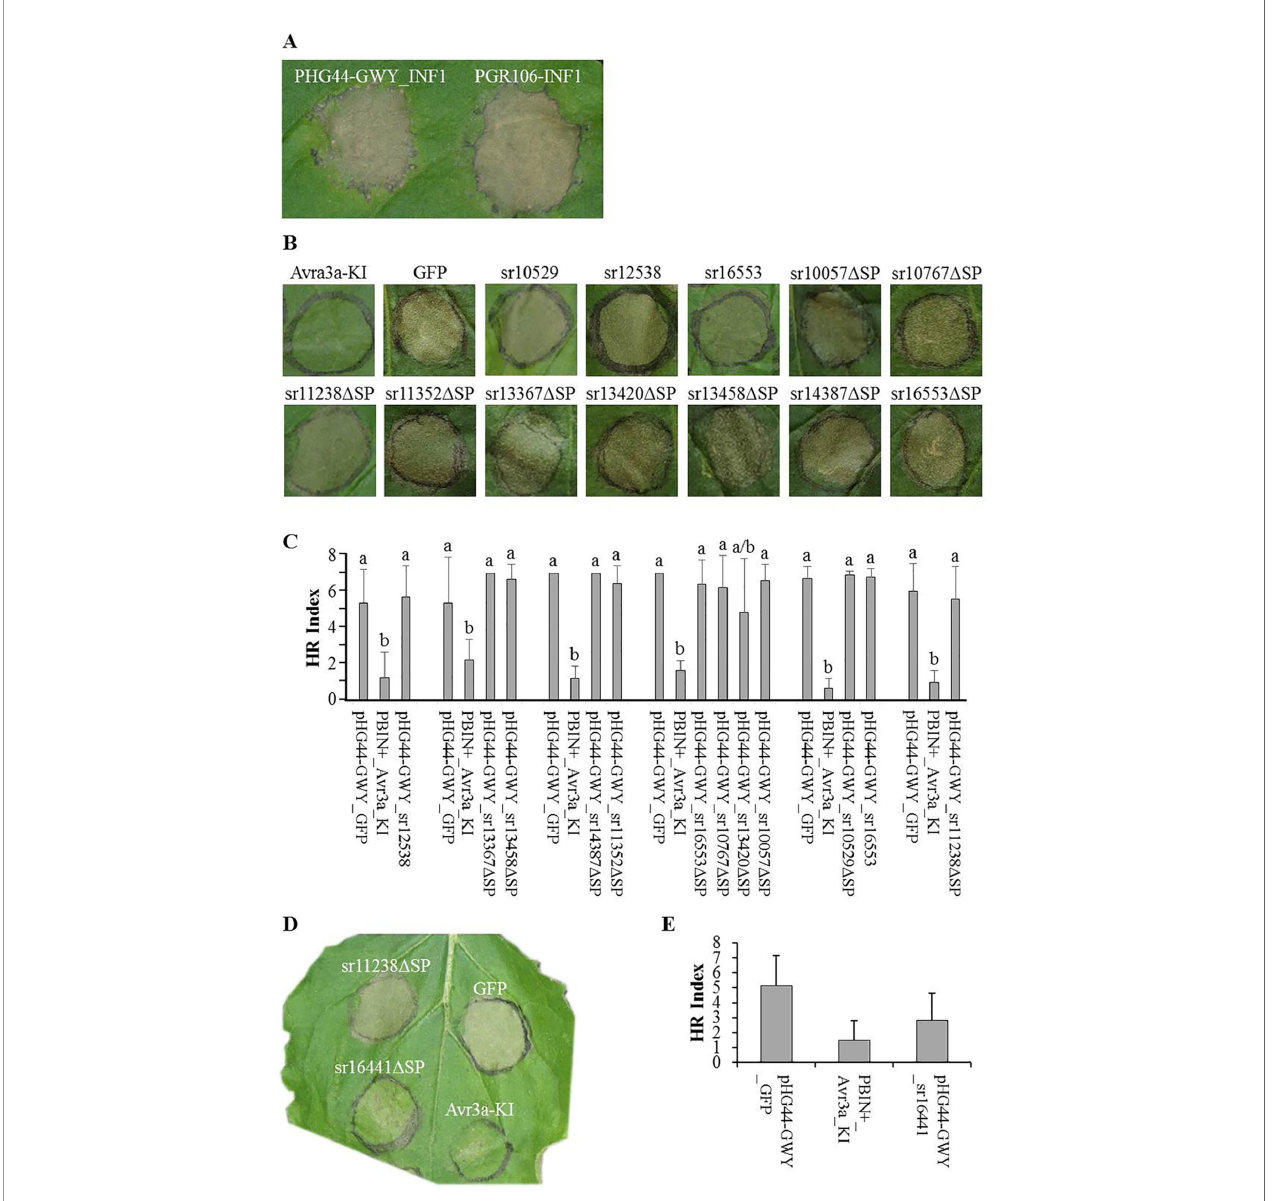
FIGURE 3 | Cell death suppression assays. Agrobacterium strains carrying effectors were in fi ltrated in N. benthamiana . Candidate effectors from Sporisorium reilianum f. sp. zeae (SRZ) were in fi ltrated along with GFP (negative control) and Avr3a-KI (positive control), one day later the in fi ltration sites were challenged with the elicitin Infestin1 (INF1). The in fi ltration sites were evaluated after 3, 4, and 5 days. Pictures were taken at day 4. (A) Transient expression of both, pHG44-GWY-INF1 and pGR106-INF1 induced necrosis of the in fi ltrated area. Although necrosis induction by pHG44-GWY_INF1 was slightly weaker, we could show that expression of pHG44-GWY led to an expression strong enough to induce a cell-death response. (B) Leaves in fi ltrated with GFP and challenged with INF1 showed cell death, while leaves in fi ltrated with Avr3a-KI and challenged with INF1 did not show cell death. Furthermore, most of the constructs carrying Sporisorium reilianum f. sp. zeae (SRZ) effectors could not suppress INF1-induced cell death. (C) Quantitative comparison of the means of HR indexes of the in fi ltration sites of SRZ candidate effectors (co-in fi ltrated with pBIN61-P19) shows that they were statistically signi fi cantly higher then that from pBINplus-AVR3a-KI and had no signi fi cant difference to the means of pHG44-GWY-GFP, indicating that those candidate effectors are not able to suppress INF1-induced cell death. The experiment was conducted three times, two times without pBIN61-P19. Each column shows the mean and standard deviation. The letters above each column indicate statistically signi fi cant differences of the HR index (P < 0.01). (D) The strain carrying the predicted cytoplasmic effector sr16441 D SP could suppress INF1-induced cell death. (E) Quantitative comparison shows that the mean of HR index of pHG44-GWY-sr16441 D SP was statistically signi fi cantly lower than that of the pHG44-GWY-GFP control and was as low as that of pBINPLUS-AVR3a-KI (P < 0.01), indicating that sr16441 D SP was able to suppress INF1-induced cell death. The experiments were repeated at least three times. The percentage was calculated from 30 in fi ltration sites. Columns show the mean and standard deviation. Different letters above each column indicate statistically signi fi cant differences of the HR index (P <